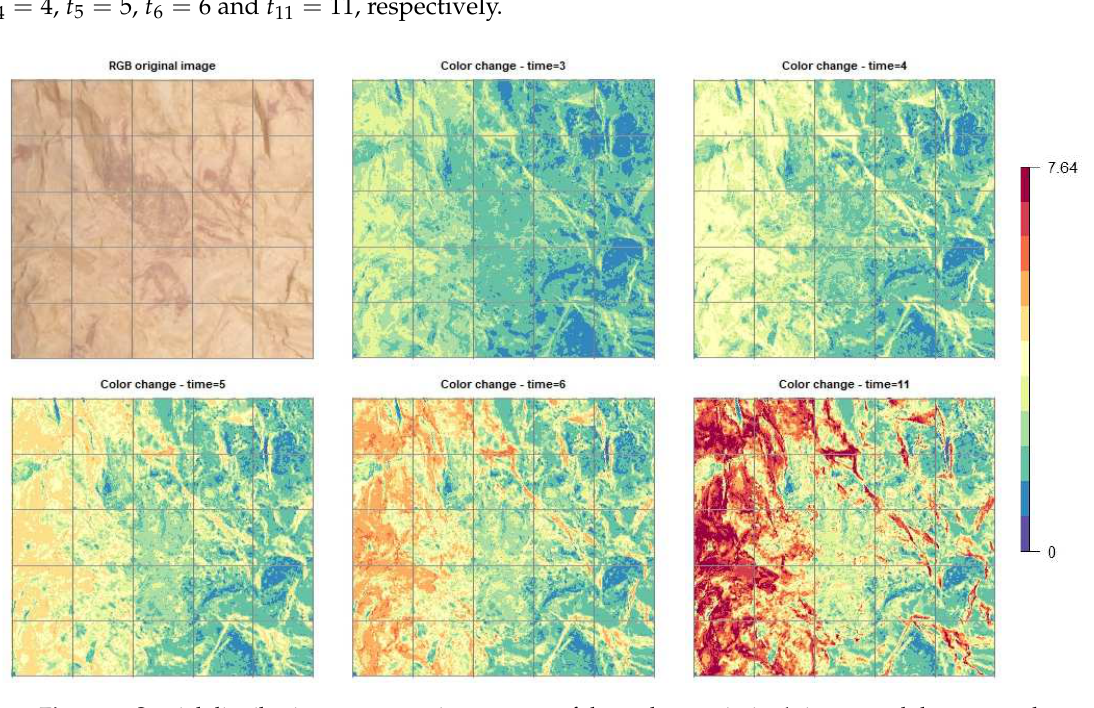
Figure 7. Spatial distribution over a continuous area of the rock art painting’s image and the temporal evolution at time points t 3 = 3, t 4 = 4, t 5 = 5, t 6 = 6 and t 11 = 11, of mean color fading